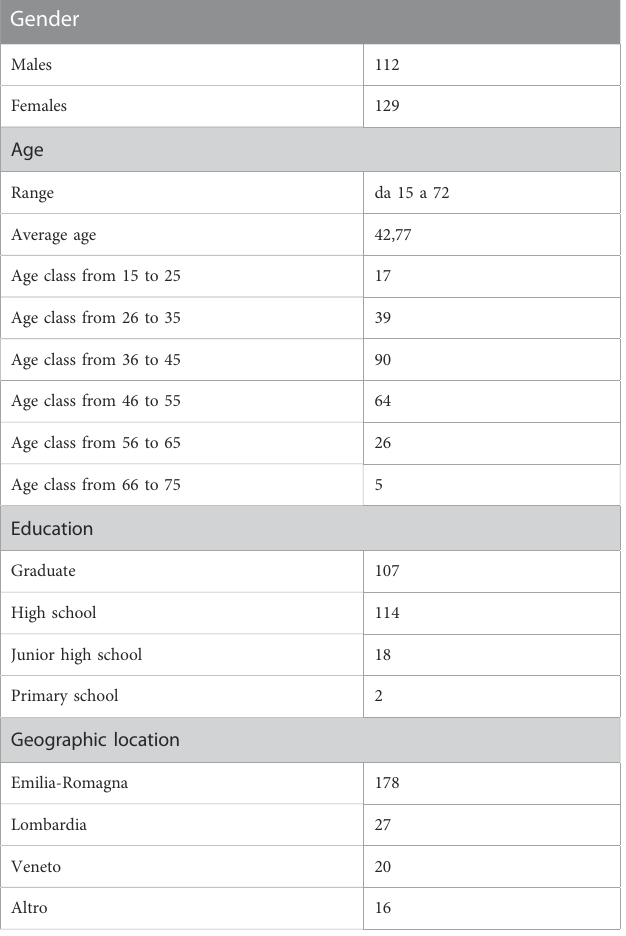
TABLE 2 Descriptive information of the web users who reported rumors during the 2012